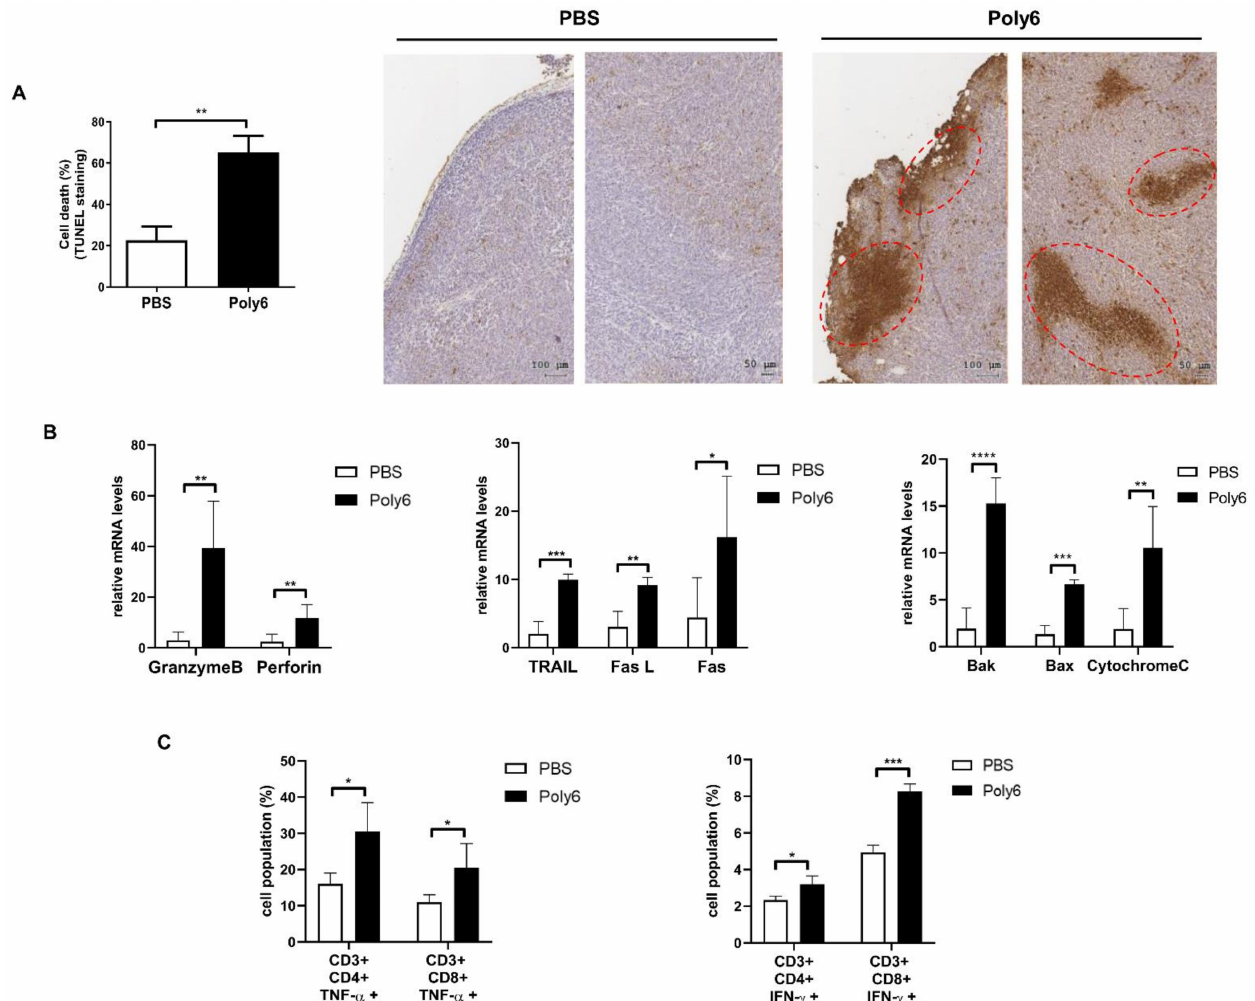
Figure 3. Poly6 exerts anticancer effects via apoptotic tumor cell death in the tumor microenvironment primarily by activating the CD8 T cell-mediated cytotoxic T lymphocyte (CTL) response. ( A ) Tumor tissues were extracted on day 19 after MC38 inoculation. Apoptotic cells in MC38 tumor tissue paraffin sections were identified by terminal deoxynucleotidyl transferase-mediated dUTP nick-end labeling (TUNEL) assay, and apoptotic diaminobenzidine (DAB) positive cells were quantified by tissue FAXS analysis. Increased apoptotic cells indicated by dashed circles. ( B ) Transcription level of death signal-inducing proteins (TRAIL, Fas ligand, Fas), cytolytic proteins (granzyme B, perforin), and pro-apoptotic proteins (Bak, Bax, cytochrome C) in MC38 tumor tissue was assessed by qRT-PCR. ( C ) Populations of TNF- α or IFN- γ producing CD4+ and CD8+ effector T cells in MC38 tumors were analyzed by FACS. Significance differences (* p < 0.05, ** p < 0.01, *** p < 0.001 and **** p < 0.0001) among different groups are shown in related figures, and the data are presented as the mean ± standard error of mean (SEM). of the mice ( n = 4). Student’s t -test was